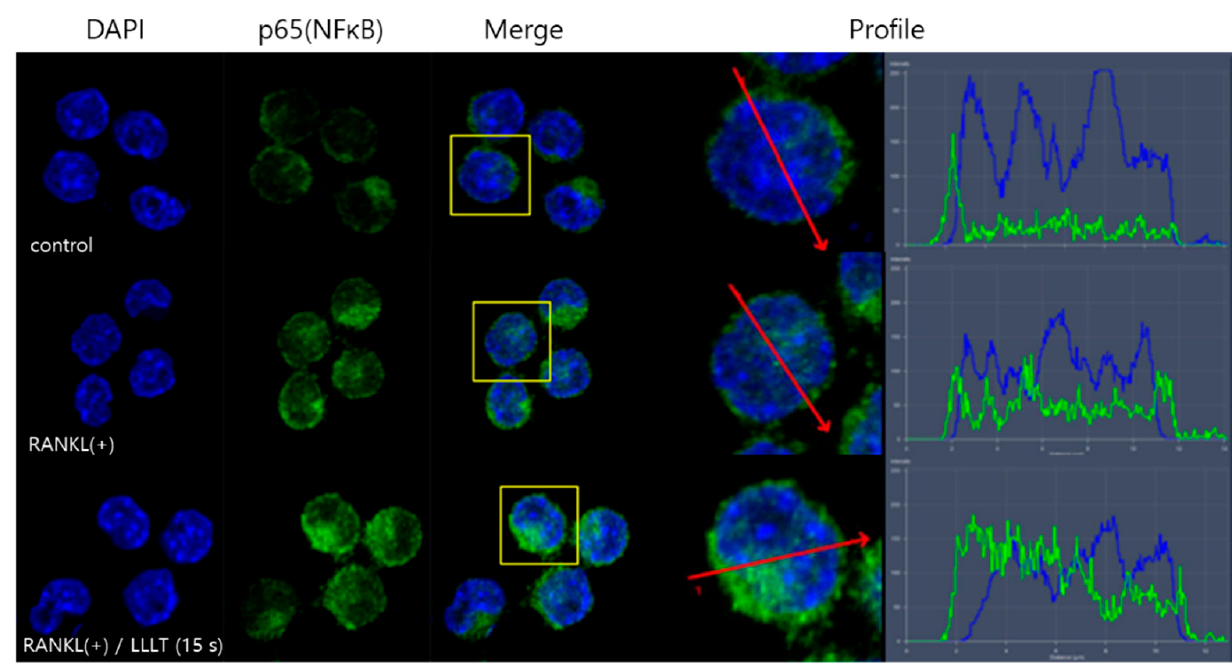
Figure 4. Effect of LLLT on NF- κ B activation in RANKL treated RAW 264.7 cells. Using confocal microscopy, the positions of the nuclei stained with DAPI (blue) and the p65 protein stained with green fluorescence were confirmed. The location of p65 was expressed as a peak (right panel) through